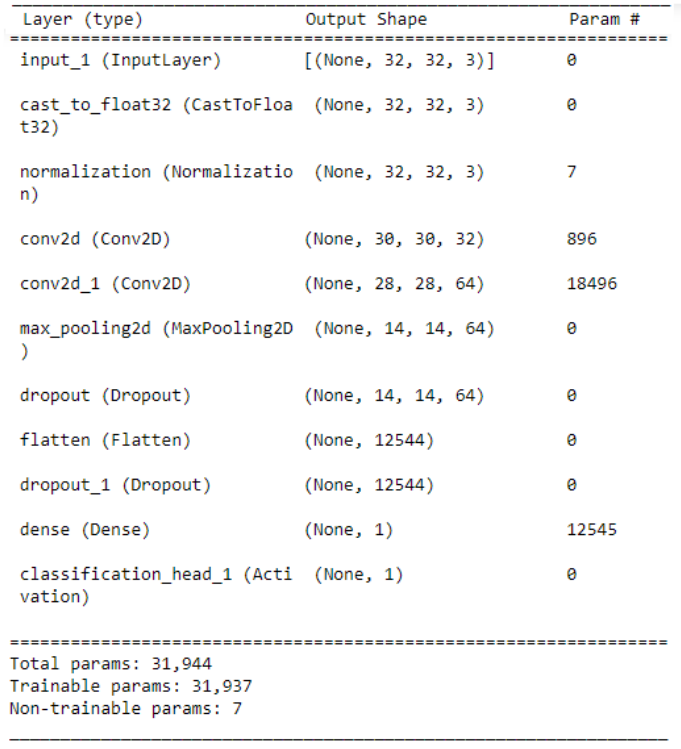
Figure 6. The best network architecture provided by the AutoKeras model from 20 trials.